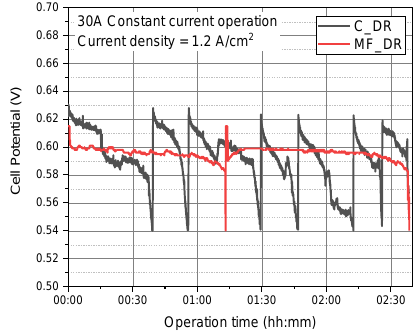
Figure 10. Voltage variations during long-term operation.